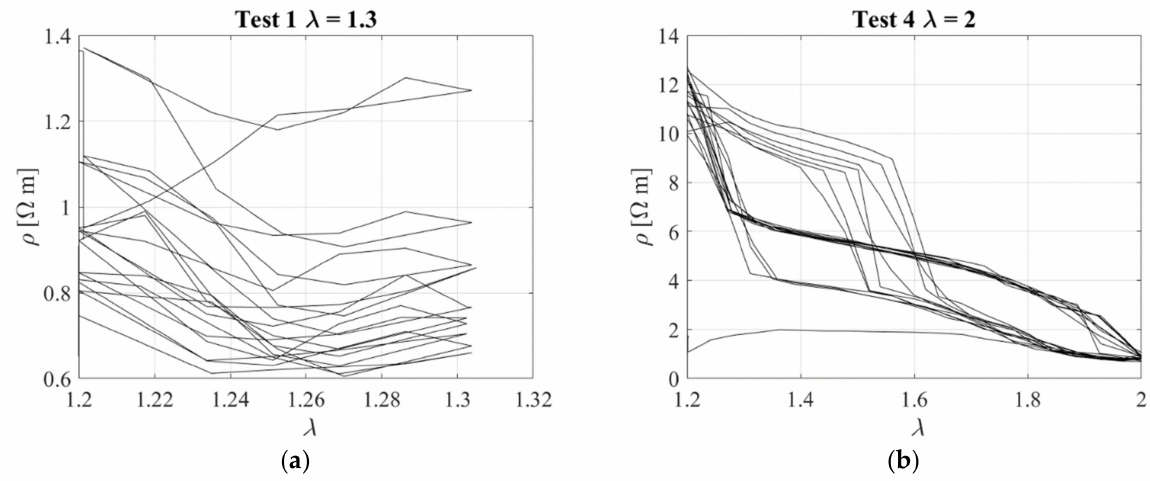
Figure 11. Resistivity vs. stretch ratio Test 1 ( a ) and Test 4 ( b ).